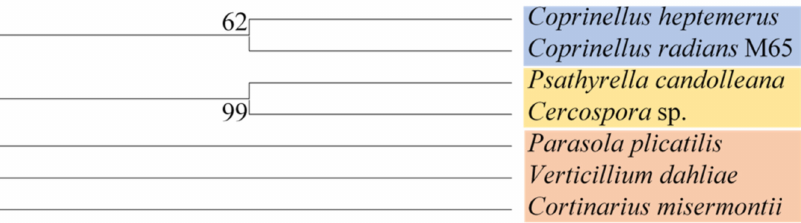
Figure 4. The evolutionary analysis tree constructed with selected fungi producing guanacastane diterpenoids. The evolutionary analysis was reconstructed by the maximum likelihood method from the ITS sequences as follows: Coprinus heptemerus D99052 (JN159553.1), Coprinus radians M65 (HM045514.1), Coprinus plicatilis 82 ( Parasola plicatilis ) (FM163216.1), Psathyrella candolleana (MF401519.1), Cercospora sp. (KF577929.1), and Verticillium dahlia (HQ839784.1). Since the ITS se- quence of Cortinarius pyromyxa was not available, Cortinarius misermontii (NR_130230.1) was selected since their ITS sequences were the most similarly. The evolutionary analysis was conducted in MEGA X (version 10.2.2)